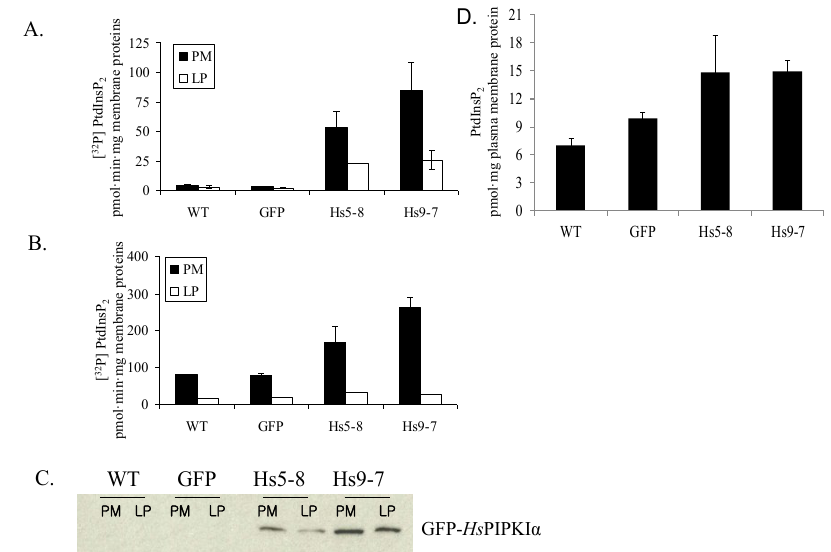
Figure 3. Membrane-associated PtdInsP 5-kinase specific activity from 17-d-old seedlings ( A ) and leaves from 1 month-old plants ( B ); The plasma membrane (PM) and lower phase fraction (LP) from wild-type and transgenic plants were separated by aqueous two-phase partitioning and analyzed for PtdInsP 5-kinase activity with added substrate, PtdIns(4)P. The data are the mean of duplicate values ± SD; ( C ) Immunoblot of proteins from PM or LP of leaves from 1-month-old plants visualized using an antibody to GFP; ( D ) Mass measurement of PtdInsP based on head group analysis of lipids extracted from isolated 2 plasma membranes of leaves from the 1-month-old